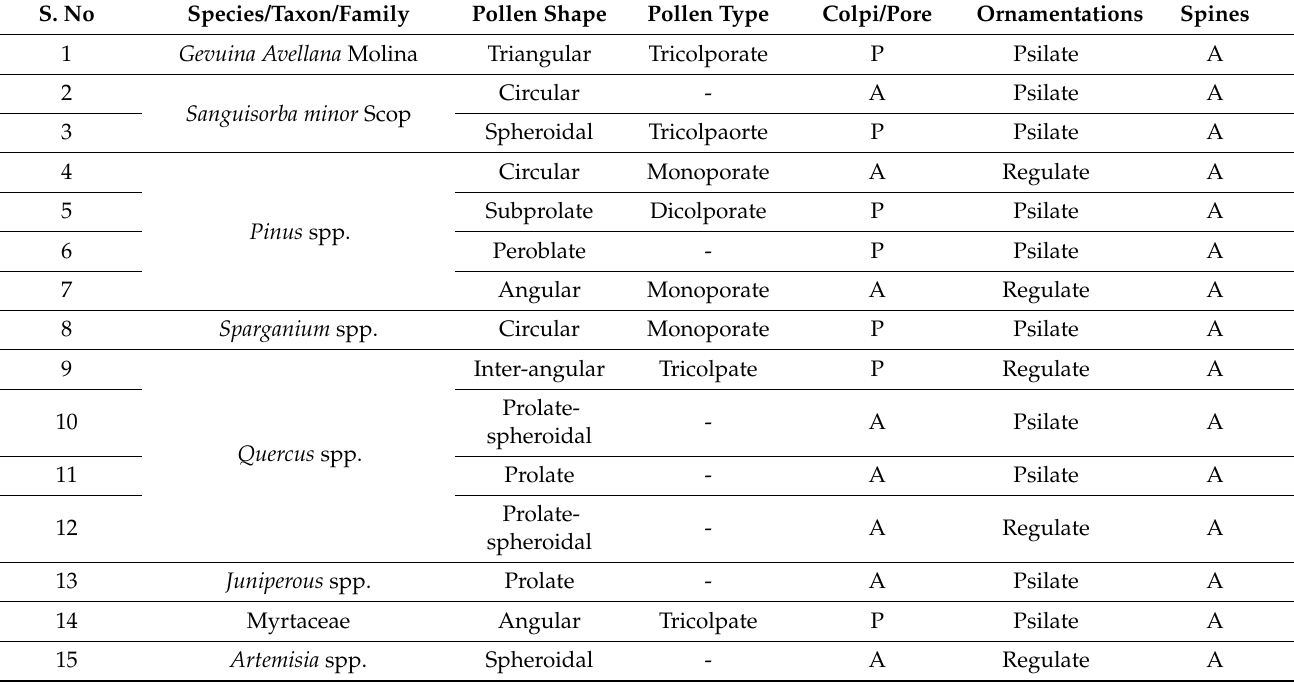
Table 1. Micromorphological characteristics of